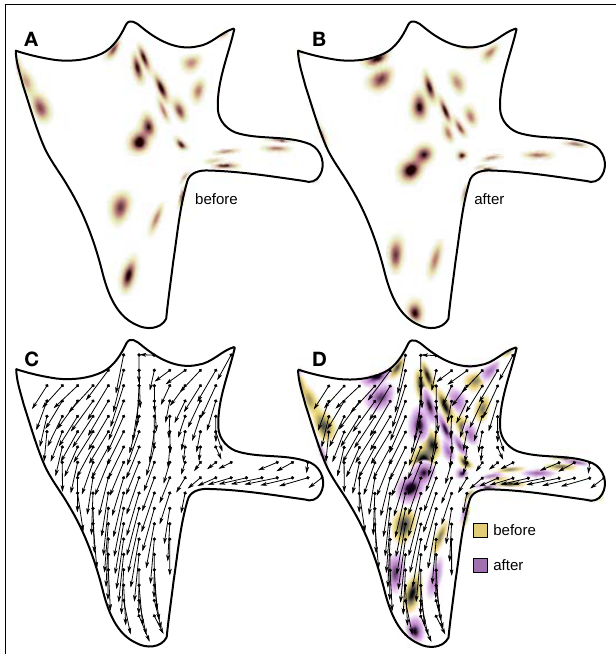
FIGURE 6 | Acquisition of φ functions . The agent scans the environment composed of random light sources before (A) and after (B) a rigid displacement caused by the agent’s jump. The corresponding function φ is illustrated in (C) with the arrows connecting points of coinciding photoreceptor outputs before (the origin of the arrow) and after the jump (the end of the arrow). (D) illustrates the meaning of the function φ , which is the field of the proprioceptive changes necessary to compensate changes in photoreceptors induced by the rigid motion